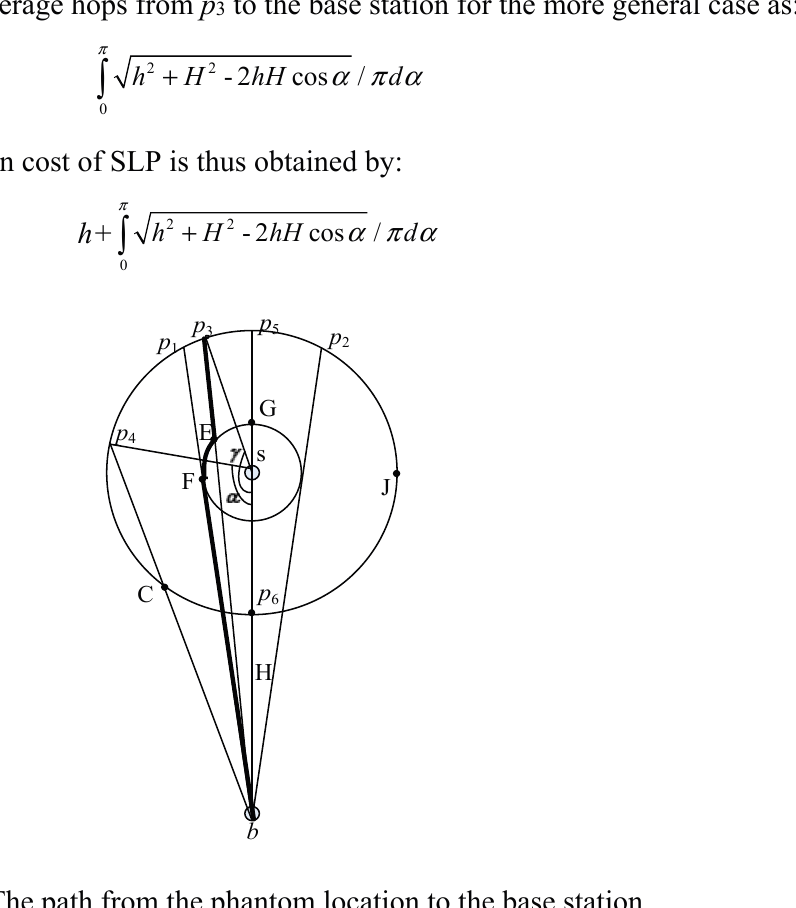
Figure 2. The path from the phantom location to the base